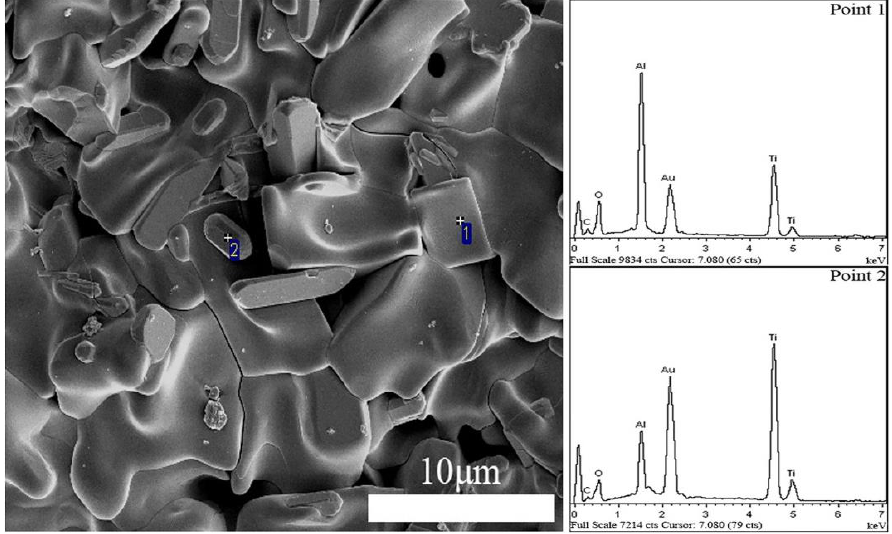
Figure 6. EDS analysis of TSC60 after oxidation at 1400 °C for 4 h.